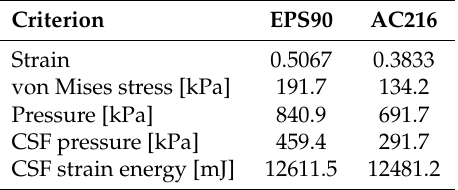
Table 9. Comparison of head injury criteria computed for helmets with AC216 and EPS90